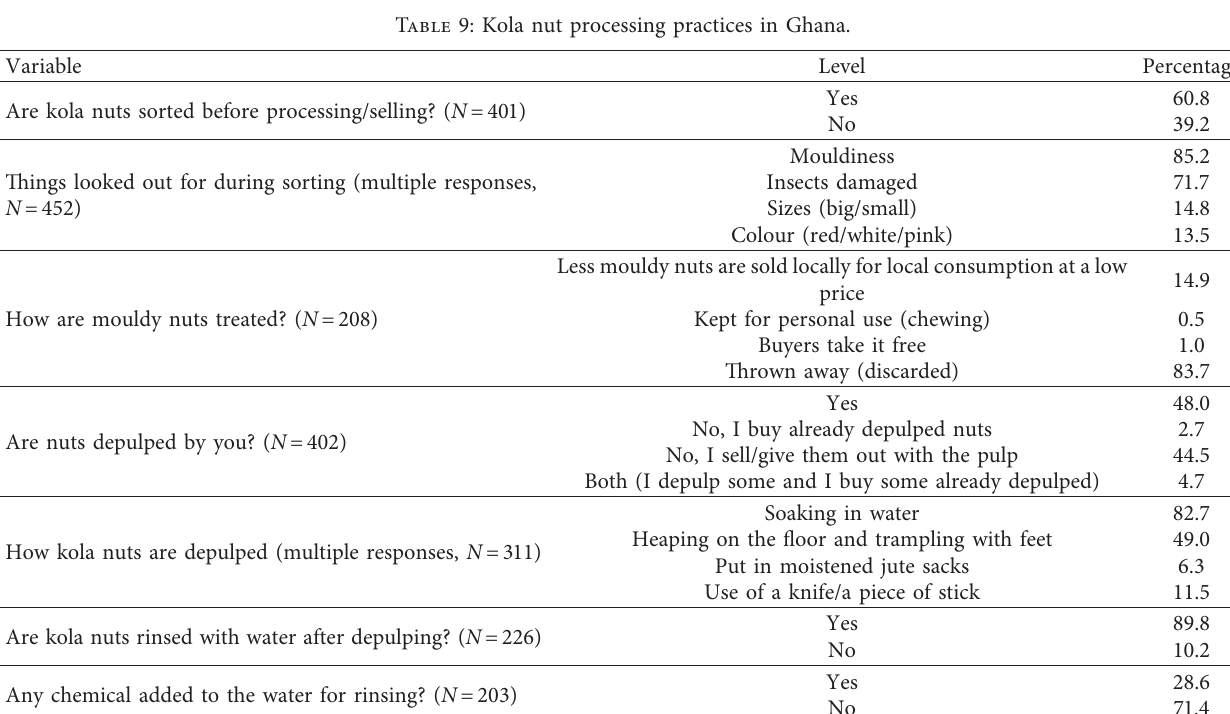
Table 9: Kola nut processing practices in Ghana.